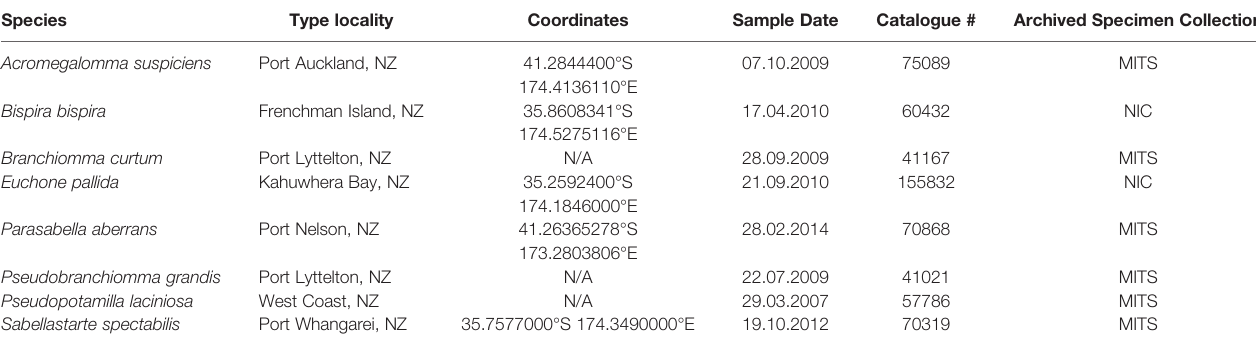
TABLE 1 | New Zealand Sabellidae species used for cross-reactivity